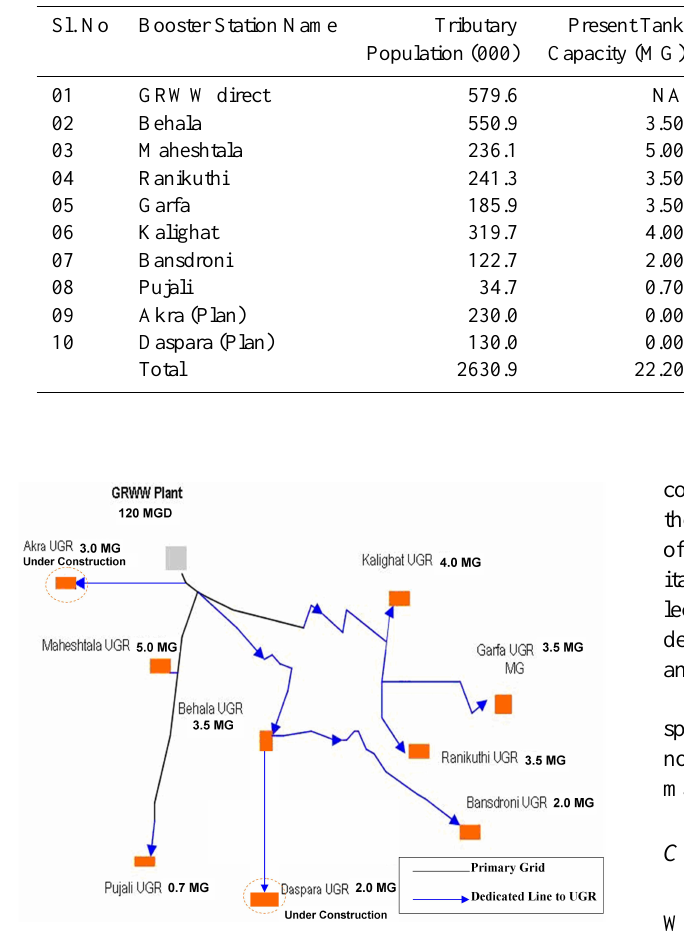
Figure 2. Water supply